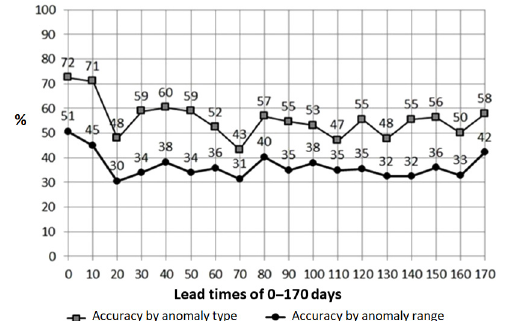
Figure 4. The same as Figure 3 for monthly precipitation amount anomaly forecasts